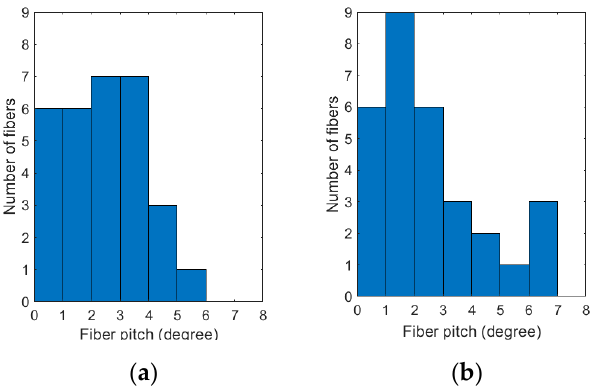
Figure 8. Fiber pitch distribution of 30 fibers measured from ( a ) X-Ray CT image of SGL 24BA 5 wt%